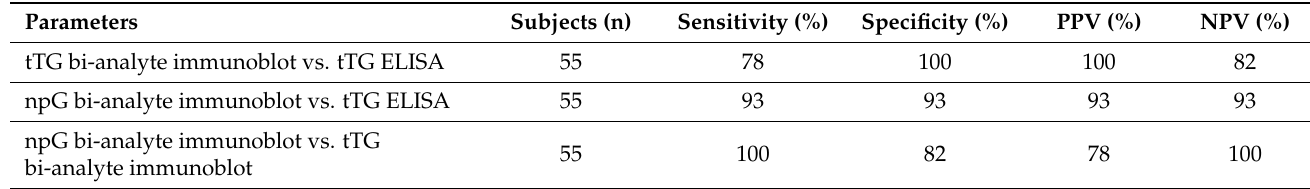
Table 3. Calculation of the diagnostic sensitivity, specificity, and predictive values of bi-analyte immunoblot in relation to monoanalyte ELISA.